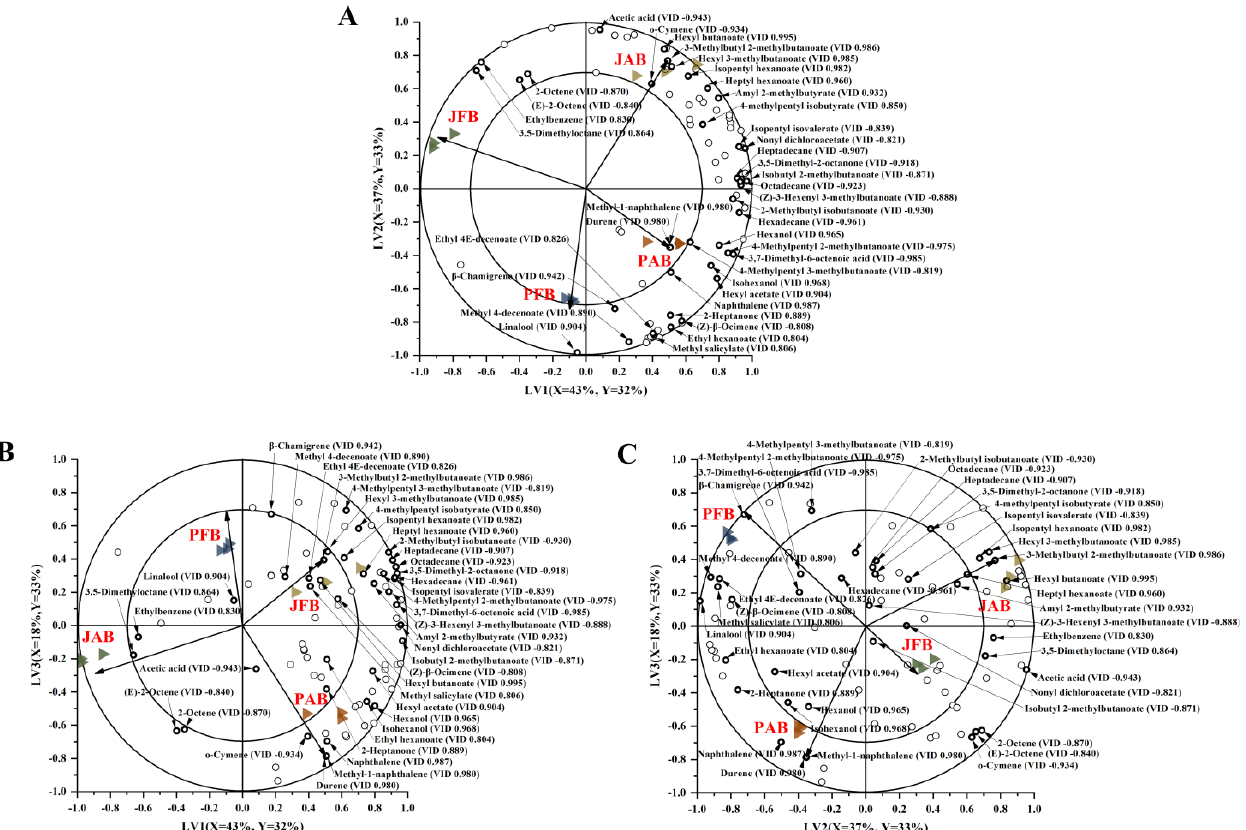
Figure 5. PLS − DA bi − plots of volatile compounds in the pool with fresh brine ( ), pool with aged brine ( ), jar with fresh brine ( ), and jar with aged brine ( ) for pickled chili peppers of different fermentation procedures ( n = 3). The X − and Y − variance explained by LV1 and LV2 ( A ), LV1 and LV3 ( B ), LV2 and LV3 ( C ) were indicated in the respective axes. The open circles show different volatiles. The discriminant volatiles with absolute VID values above 0.800 were named and marked in bold.